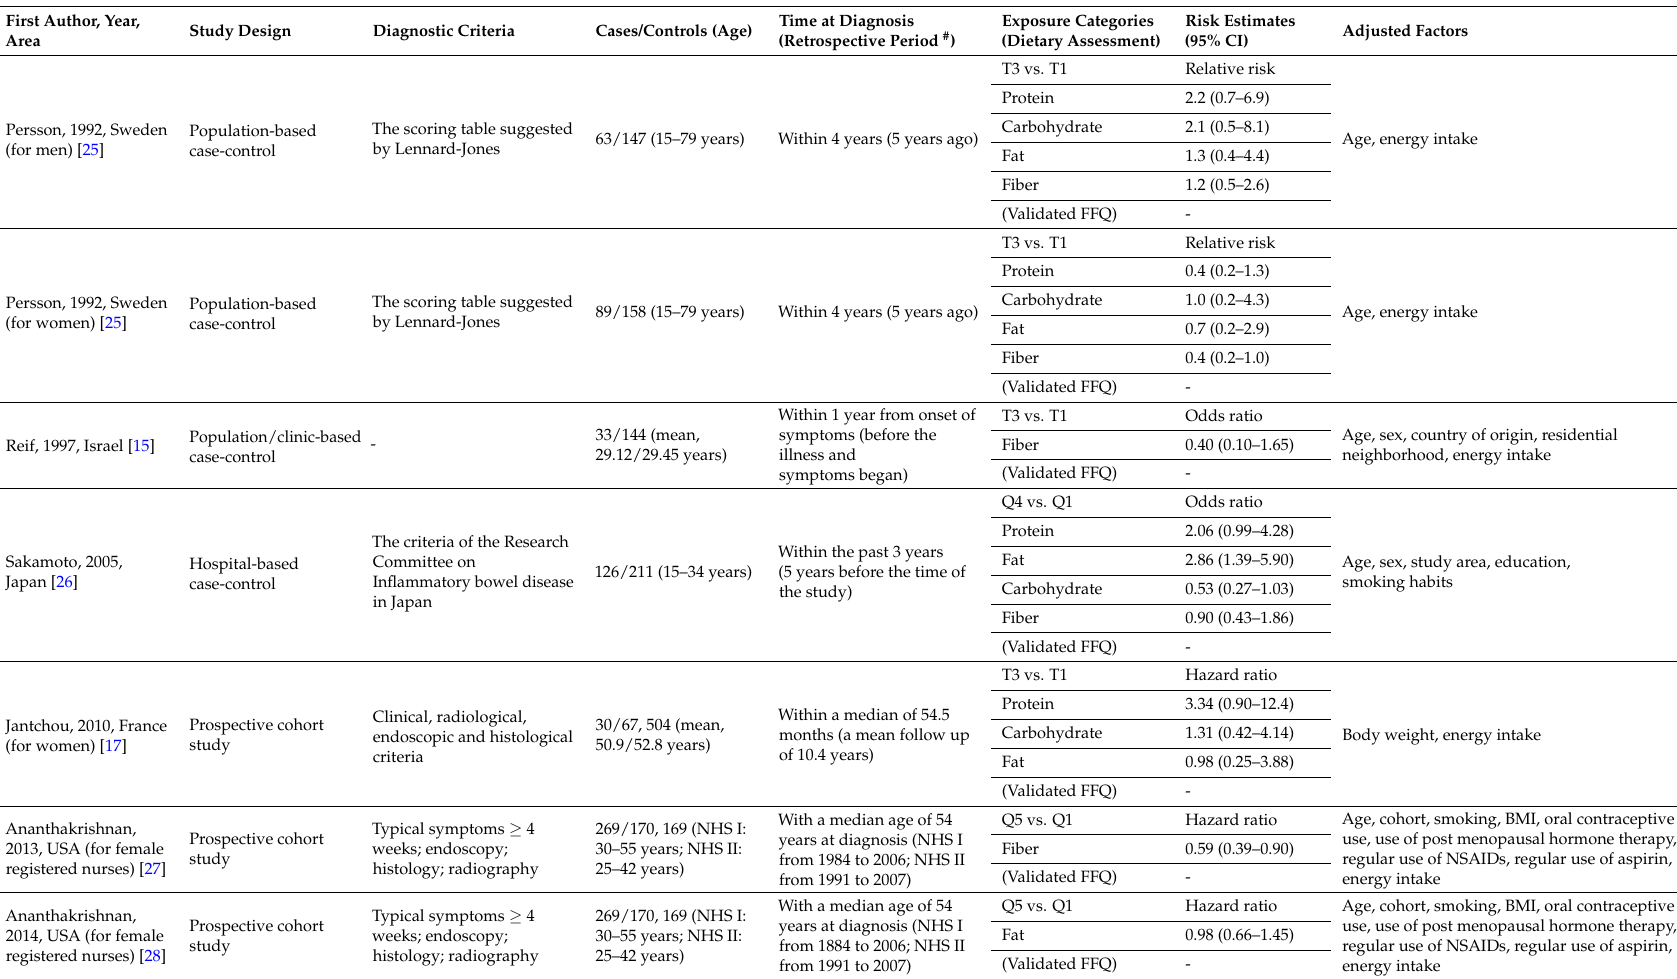
Table 1. Characteristics of included